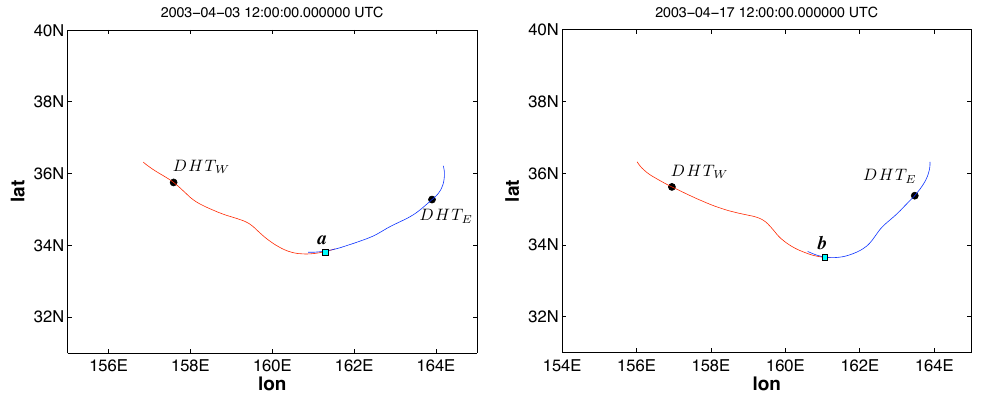
Fig. 6. Boundaries at days 3 and 17 April 2003 constructed from a (finite length) segment of the unstable manifold of DHT W and a (finite length) segment of the stable manifold of DHT E . The boundary intersection points are denoted respectively by a and b .